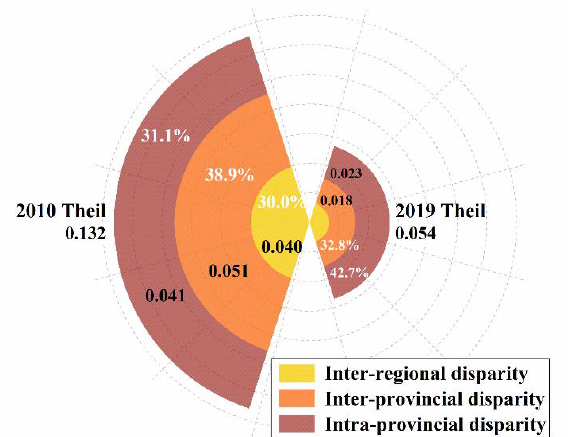
Figure 4 Contributions of spatial disparities in PM 2.5 exposure from three dimensions